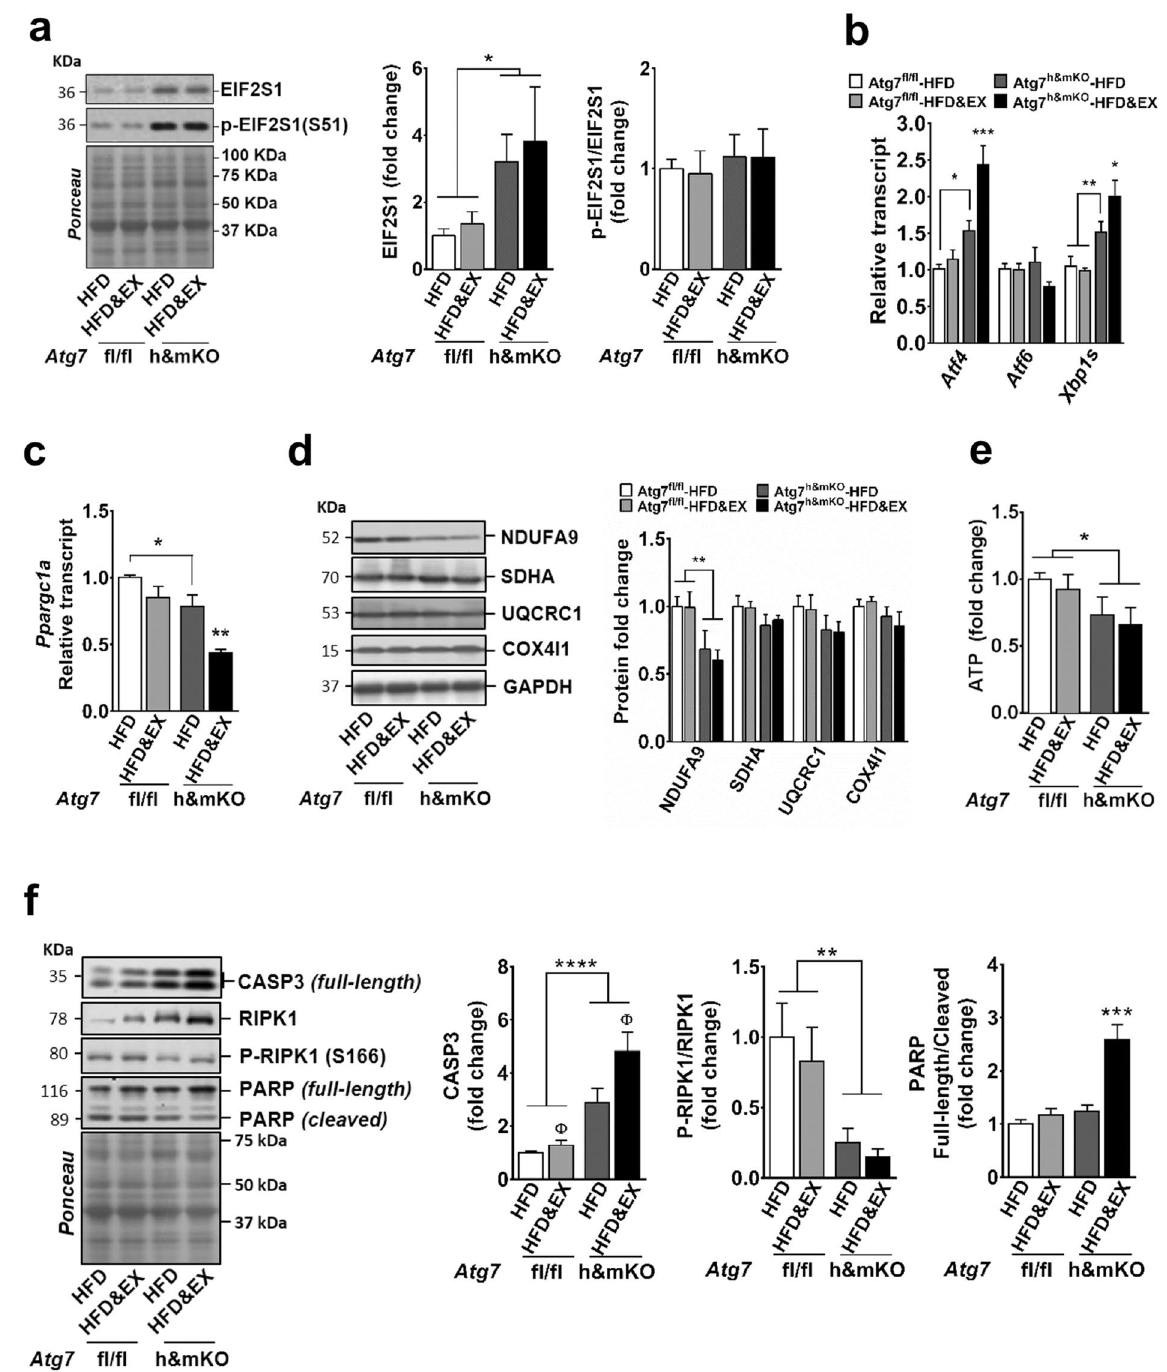
Figure 6. Exercise aggravates ER stress and fails to rescue mitochondrial protein homeostasis in the hearts of Atg7 h&mKO mice. ( a ) Immunoblot representative images of the mean value and related quantification of total EIF2S1 normalized to ponceau staining, and phosphorylated EIF2S1(S51) normalized to total EIF2S1 (n = 5–6). ( b ) mRNA analysis of ER stress effector genes (n = 5–9). ( c ) mRNA analysis of Ppargc1a (n = 5–7). ( d ) Immunoblot representative images of the mean value and related quantification of mitochondrial proteins of complexes 1–4 of the Electron Transport Chain normalized to GAPDH (n = 5–6). ( e ) Quantification of ATP levels in heart homogenates (n = 5–8). ( f ) Immunoblot representative images of the mean value and quantification of select cell death-related proteins (n = 5–6). Full-length blots are presented in Supplementary Fig. S7. * P < 0.05, ** P < 0.01, *** P < 0.001 and **** P < 0.001 in comparison to all other groups, unless otherwise represented; Φ P < 0.05 in comparison to respective HFD only, sedentary